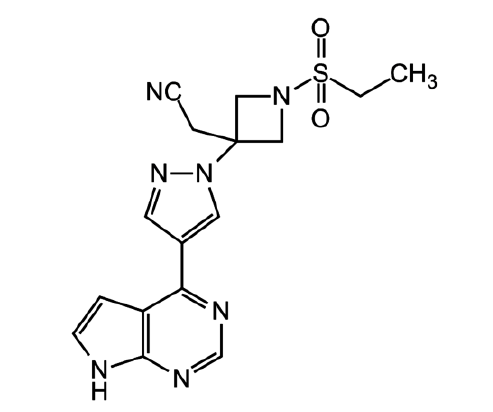
Fig.1. Chemical structure of